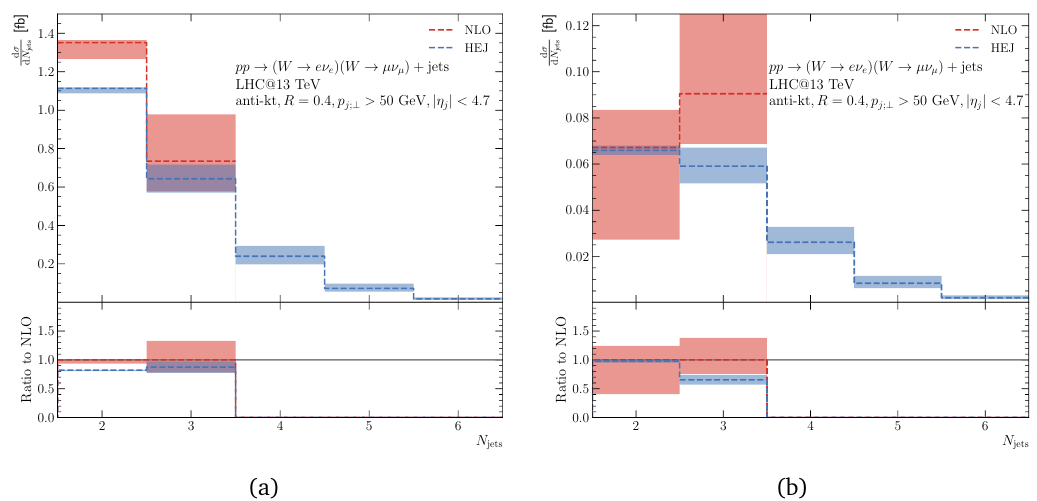
Figure 2: Exclusive jet rates for pp → W ± W ± + ≥ 2 j , without (a) and with (b) the additional VBS cuts.